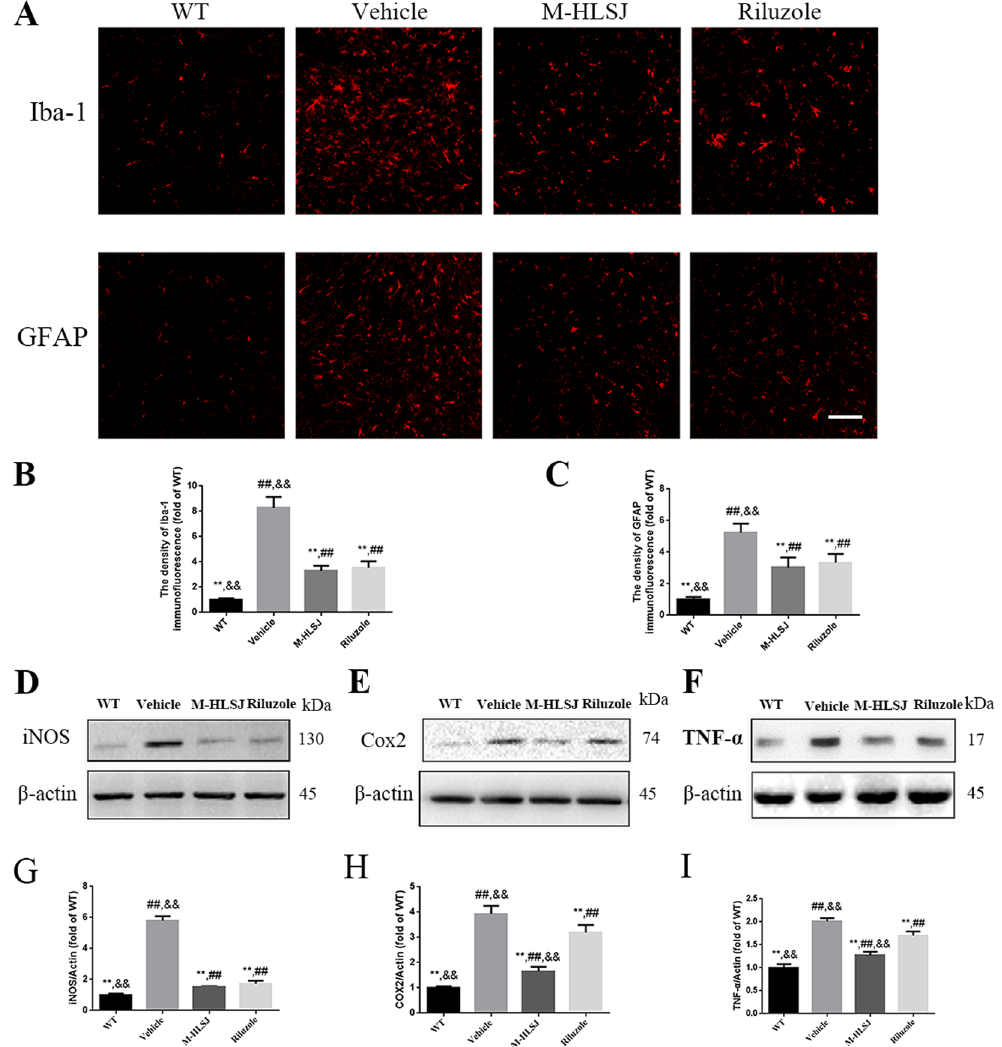
Figure 7. Effects of HLSJ on the activation of glial cells and the expression of inflammation-related proteins in the spinal cords. ( A ) Anti-Iba-1 and anti-GFAP immunostaining photomicrographs, scale bar = 50 μ m; The quantitative analysis of ( B ) Iba-1 and ( C ) GFPC immunofluorescence, n = 30 in each group. The western blot analysis of the protein levels of ( D ) iNOS, ( E ) Cox2 and ( F ) TNF- α . The quantitative analysis of the expression ( G ) iNOS, ( H ) Cox2 and ( I ) TNF- α , n = 3 in each group. Significant differences with vehicle group at ** P < 0.01. Significant differences with WT group at ## P < 0.01. Significant differences with riluzole group at && P <